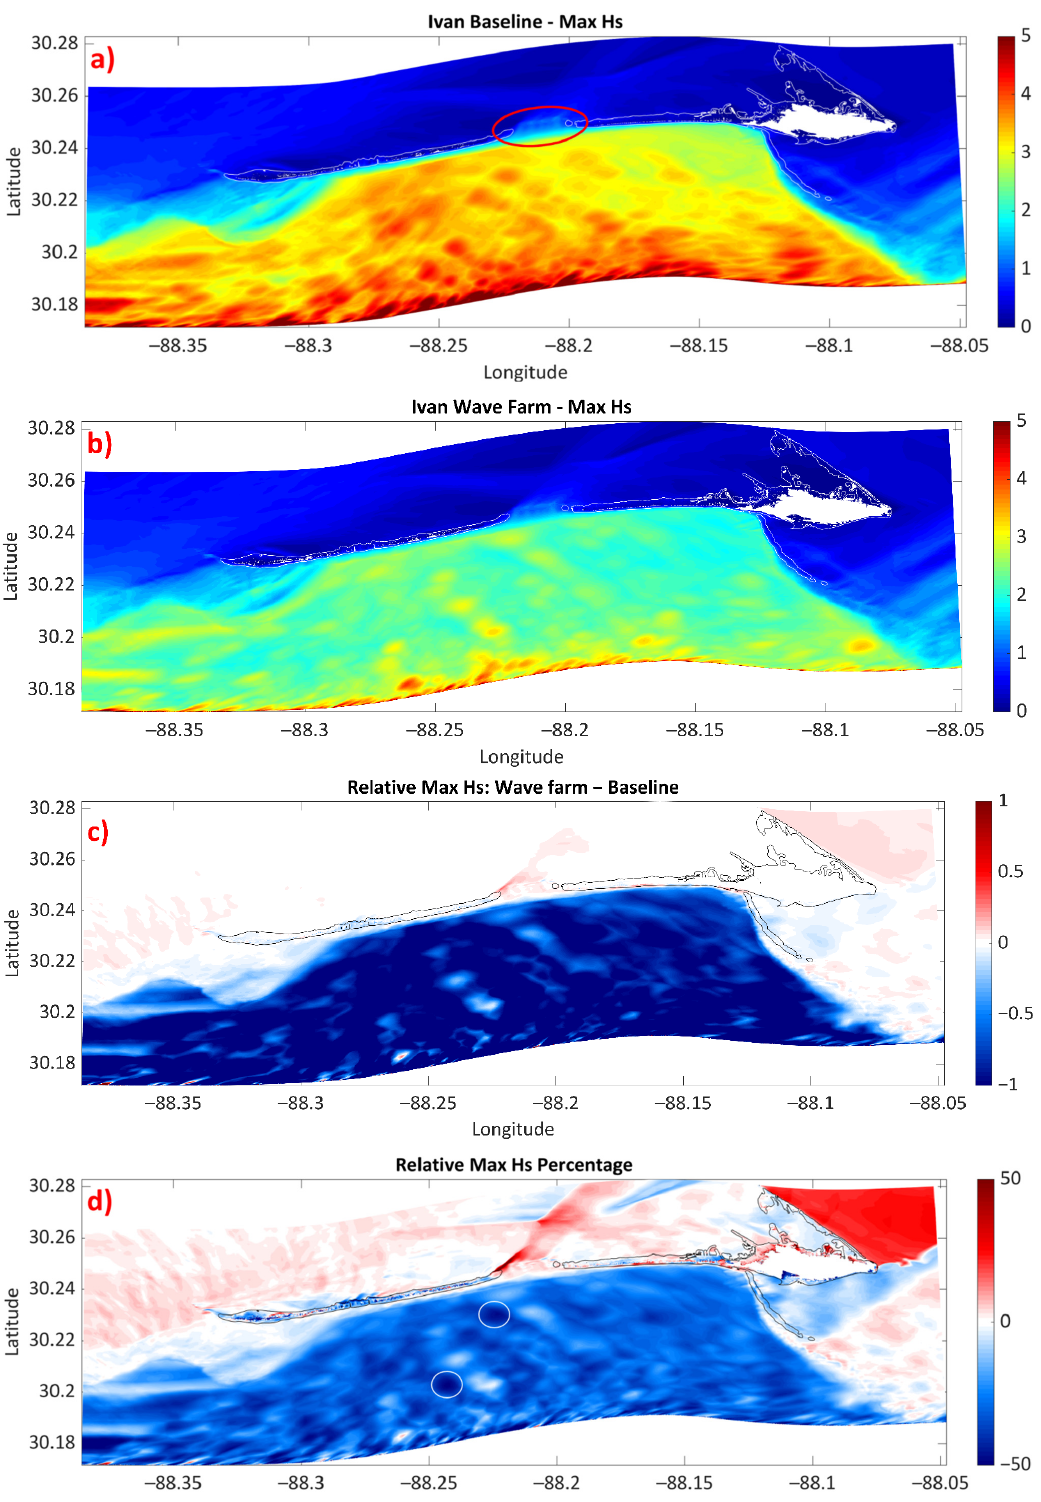
Figure 7. Hurricane Ivan maximum wave heights (Hs) across the domain of Dauphin Island, AL: ( a ) baseline scenario [m], ( b ) wave farm scenario [m] ( c ) Hs difference between the two scenarios in [m] where baseline values are subtracted from wave farm values. ( d ) Hs difference in [%]. White circles are some of the locations where the reduction in Hs exceeds 50% in the wave farm scenario. The blue color represents the reduction in Hs due to wave energy converter devices (WECs), and the red color represents the increase in Hs due to WECs. White and black lines are the poststorm zero-meter contours of the island. The location of the Katrina Cut is marked with a red circle in ( a ).